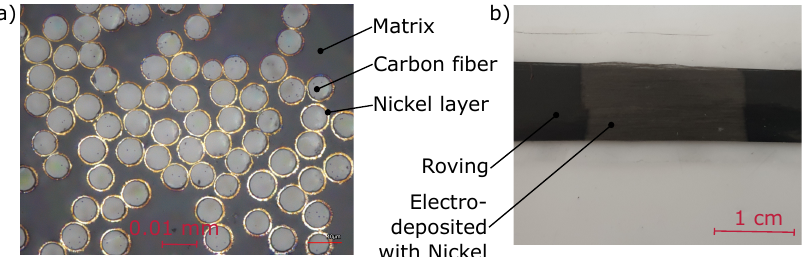
Figure 13. Future development of locally electroplated carbon fiber rovings for the automated pultrusion of Self-Strain-Sensing carbon fiber rods with ( a ) showing a typical cross section of an electroplated specimen and ( b ) showing a macroscopic picture of the localized